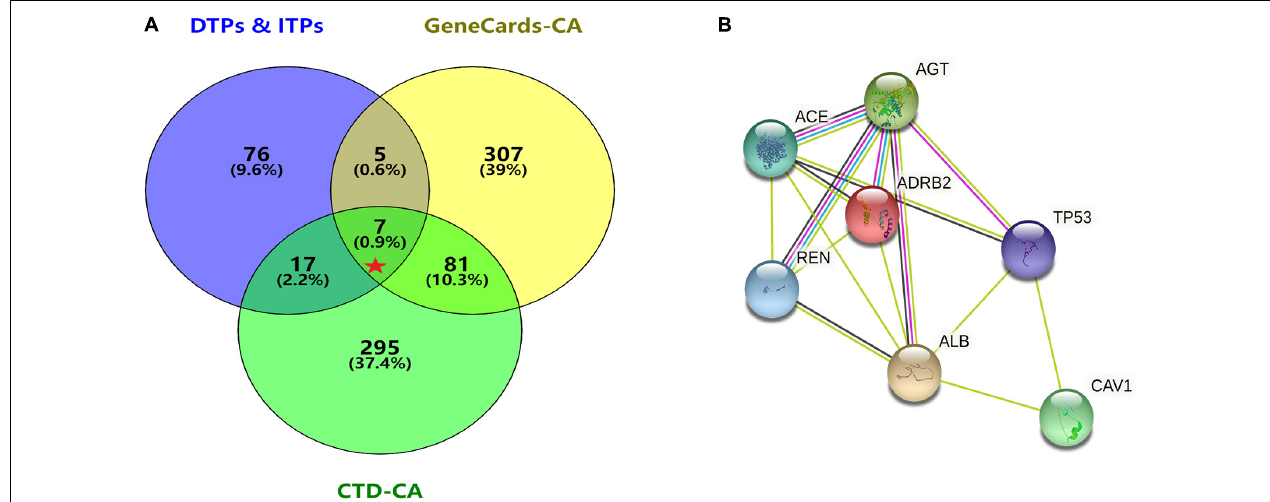
FIGURE 4 | Acquisition of core target proteins and protein-protein interaction network. (A) SV-related drug target proteins [DTPs and indirect target proteins (ITPs)] were obtained from Drugbank Data and STRING. The top 400 CA-related genes were selected from GeneCards and CTD. The intersection of drug target protein genes (DTPs and ITPs) and the top two CA-related genes were selected by the Venn diagram. There were seven core target proteins (Red Pentagram). (B) A PPI network of the antiarrhythmic targets of SV was generated by the STRING database with medium confidence